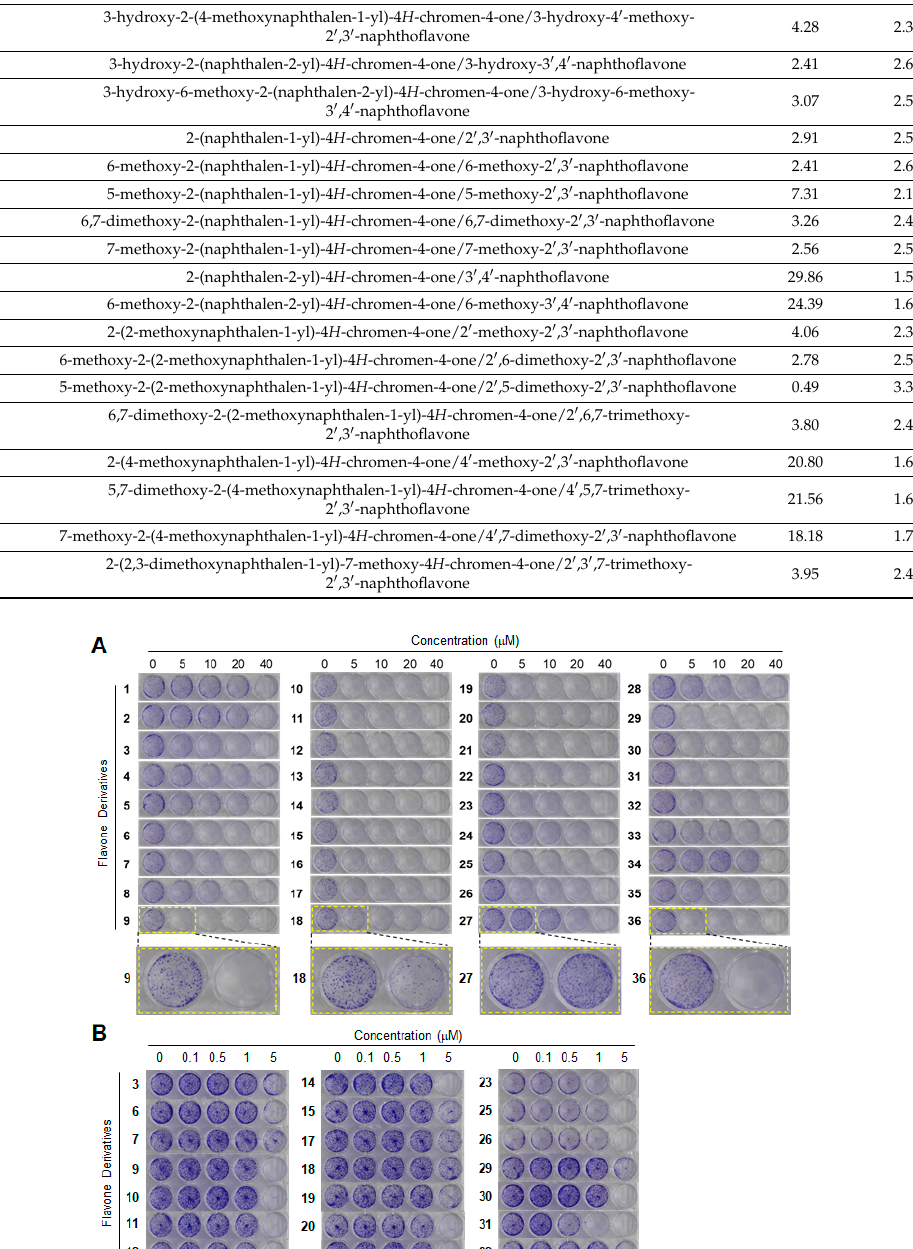
Figure 2. Half-maximal cell growth inhibitory concentration (GI 50 ) values in Table 1.